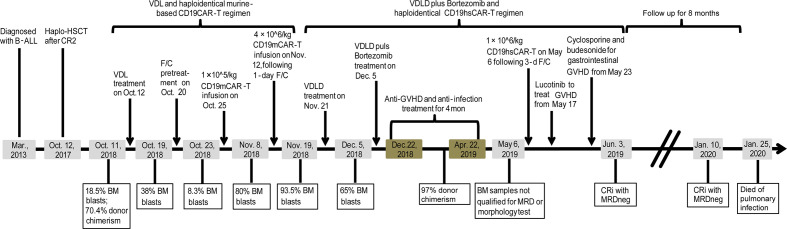
Time line of major treatments and outcomes for the patient.